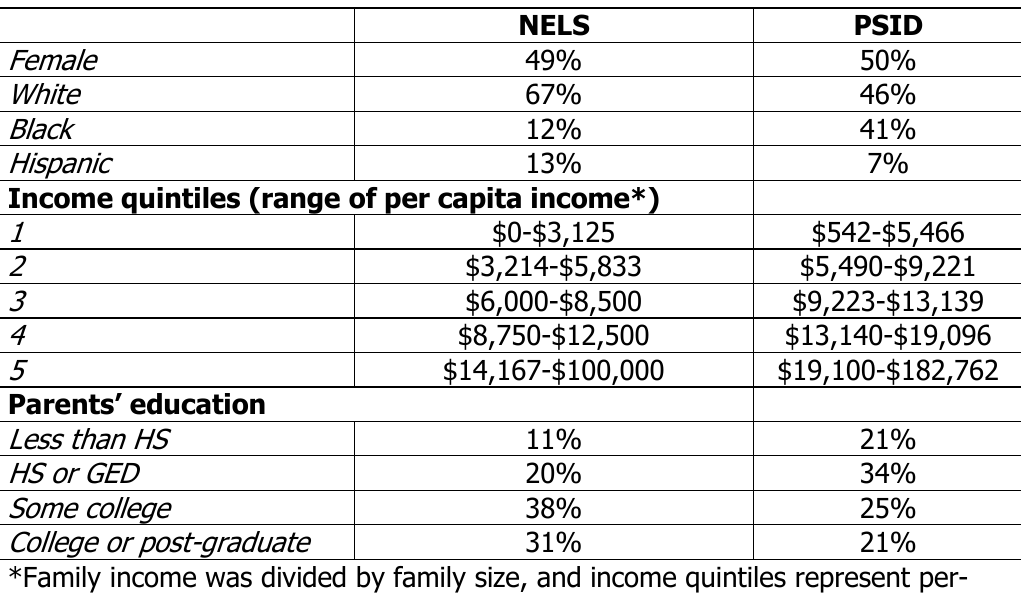
Demographic Distribution of NELS and PSID samples